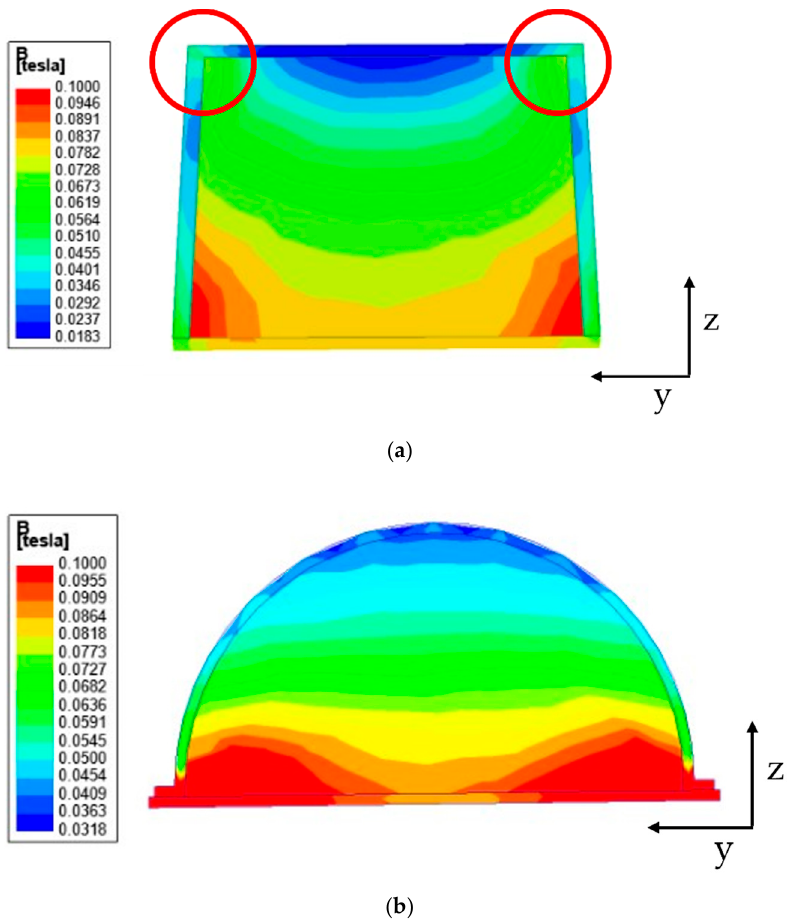
Sensors 2021 , 21 , x FOR PEER REVIEW Figure 8. Magnetic field analysis results: ( a ) rectangular parallelepiped type, ( b ) hemispherical type.